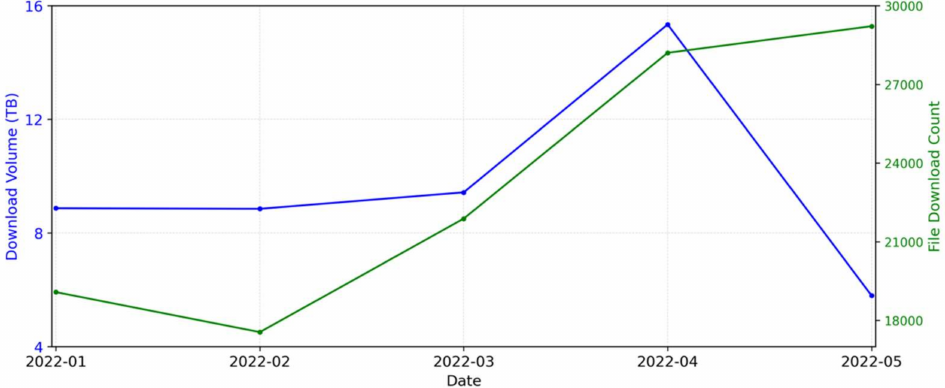
Figure 6. CDAAC COSMIC-2 data download volume and files in